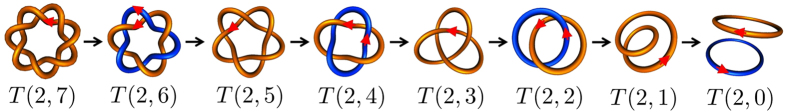
Cascade of torus knots and links produced by single reconnection events.Time sequence of a cascade of torus knots (orange online) and links (blue and orange online) produced by single reconnection events, that consistently reduce topological complexity by stepwise unlinking: in the example the torus knot T(2, 7) is shown to gradually decay to a pair of unknotted, unlinked loops T(2, 0) through the alternate production of distinct torus knots and links.